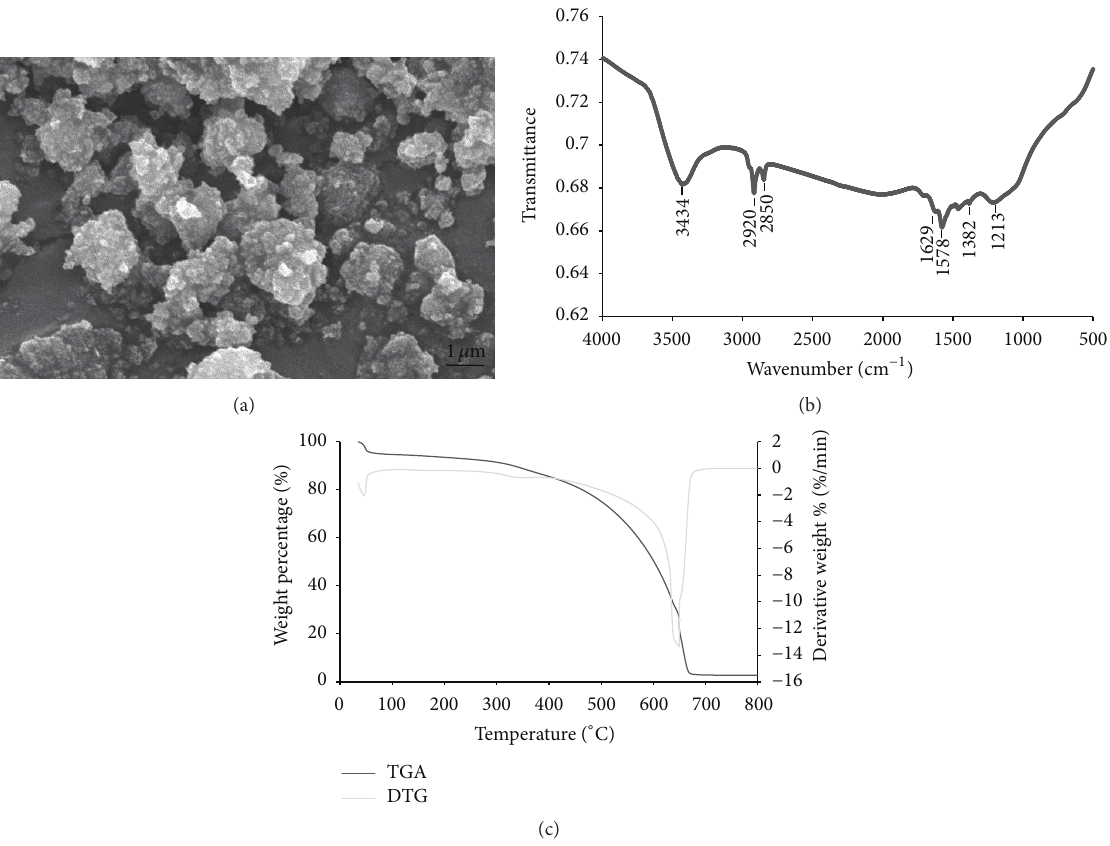
wavelength of 2920 cm −1 and 2850 cm −1 are believed to be the aliphatic compound found on the surface of